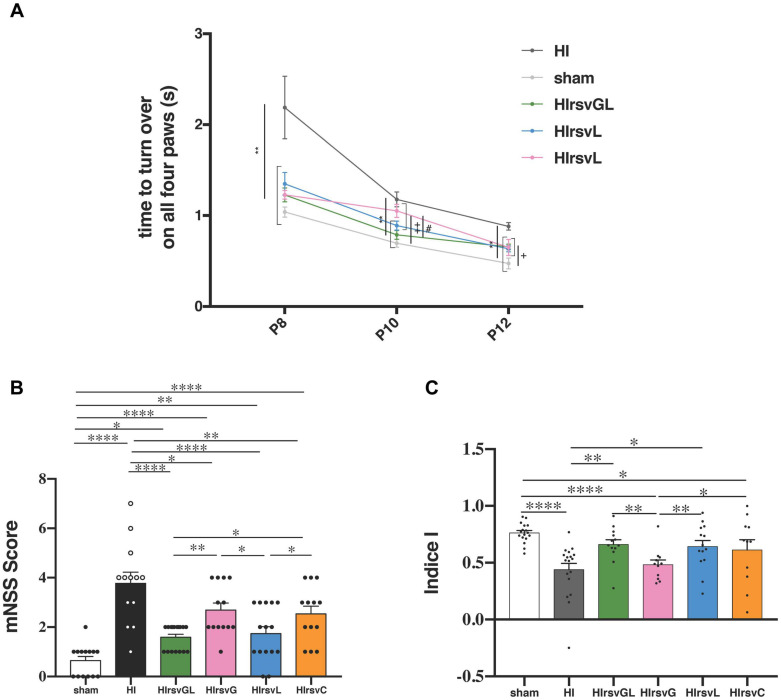
Behavioral investigations. (A) Righting reflex for sham, HI, HIrsvGL, HIrsvG, and HIrsvL groups (n = 23, n = 20, n = 17, n = 12, and n = 15, respectively) at P8, P10, and P12. (B) mNSS score at P24 for sham, HI, HIrsvGL, HIrsvG, HIrsvL, and HIrsvC groups (n = 14, n = 13, n = 17, n = 13, n = 15, and n = 13, respectively). Scoring between 0 and 18 points with: <1, no impairment; 1–6, moderate impairment; 7–12, impairment and 13–18, severe impairment. ∗: different from the HI group (∗∗: p < 0.01), +: different from the sham group (+: p < 0.05, ++: p < 0.01) and #: different from the HIrsvGL (p < 0.05). (C) Discrimination index of the novel object recognition test (performed at P45) for sham, HI, HIrsvGL, HIrsvG, HIrsvL, and HIrsvC groups (n = 17, n = 17, n = 13, n = 10, n = 14, and n = 11, respectively). Results are mean values ± SEM; one-way analysis of variance (ANOVA) with Fisher’s LSD post hoc test. ∗: Significant difference between two groups (∗: p < 0.05, ∗∗: p < 0.01, and ****: p < 0.0001).